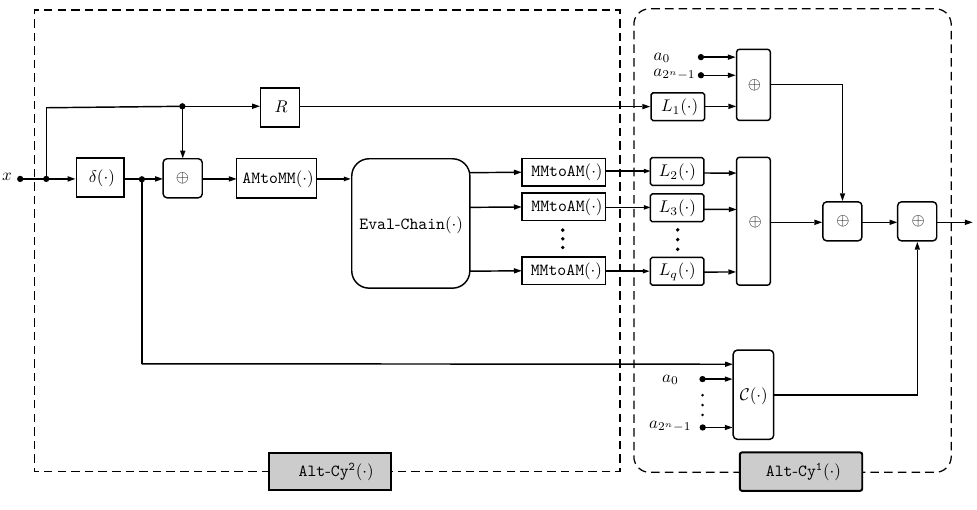
Figure 4: Gadget Alt - Cy ( · ) : circuit of the alternate cyclotomic